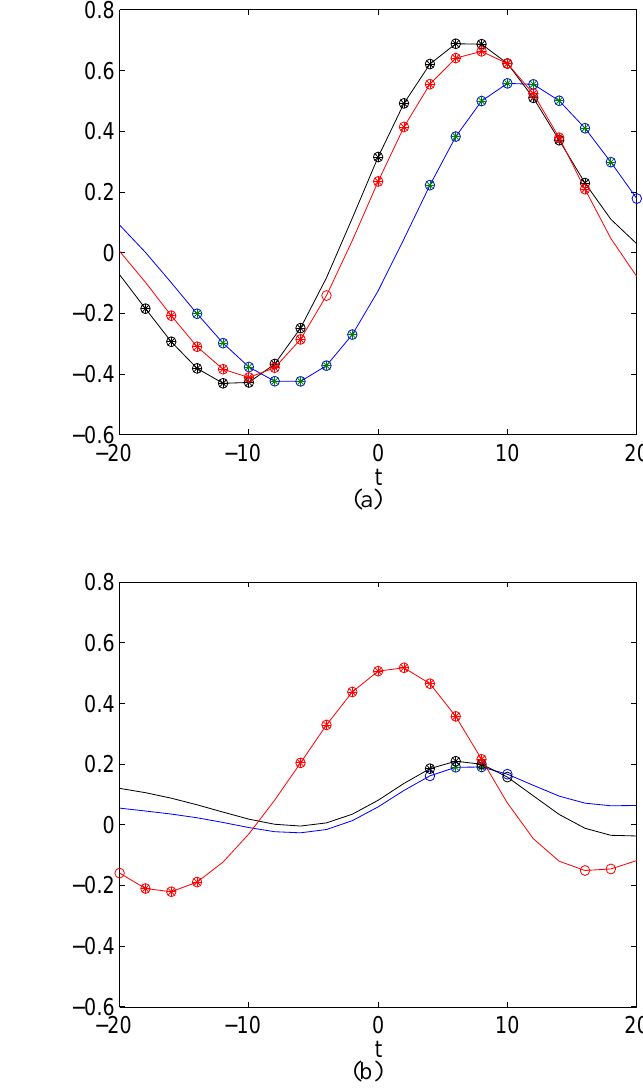
Fig. 13. Correlations of mixing rates for the BL inflow box lagged by t to maximal tangential winds with (a) 20 min. and (b) 30 min. integration time for FMR (red), FRD (black), and MMR (blue). Filled circles indicate correlation above a 99% confidence thresh- old, while open circles indicate correlations above 95% but below 99% confidence.